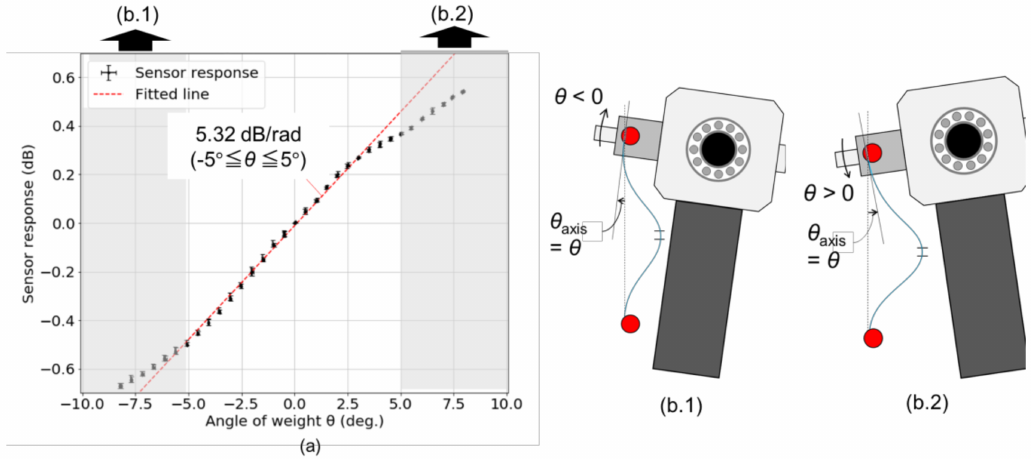
Figure 4. ( a ) Optical loss variation of a hetero-core optical fiber inside a proposed accelerometer as functions of angle of weight, θ ; and ( b.1 , b.2 ) schematics of excess changes in the axial angle of the optical fiber line, θ axis , due to the rotation movement of fixed point on the